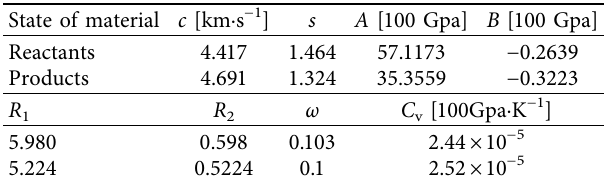
Table 2: Parameters of the Johnson–Cook constitutive model for #45 steel.